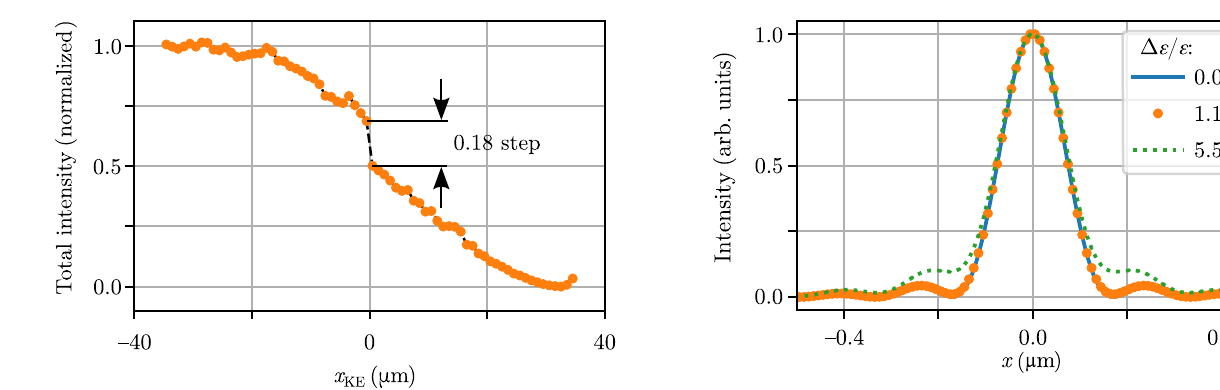
FIG. 4. Knife-edge scan of the 0.18-NA zone plate over a wider range that examines all undiffracted light as well as higher-order foci. The slow drop corresponds to a 32 - μ m XUV beam, while the sharp drop in the middle corresponds to the first-order focus [a finer scan in this region is reported in Fig. 2(b)]. The focused XUV contains 18% of the total emitted photons.